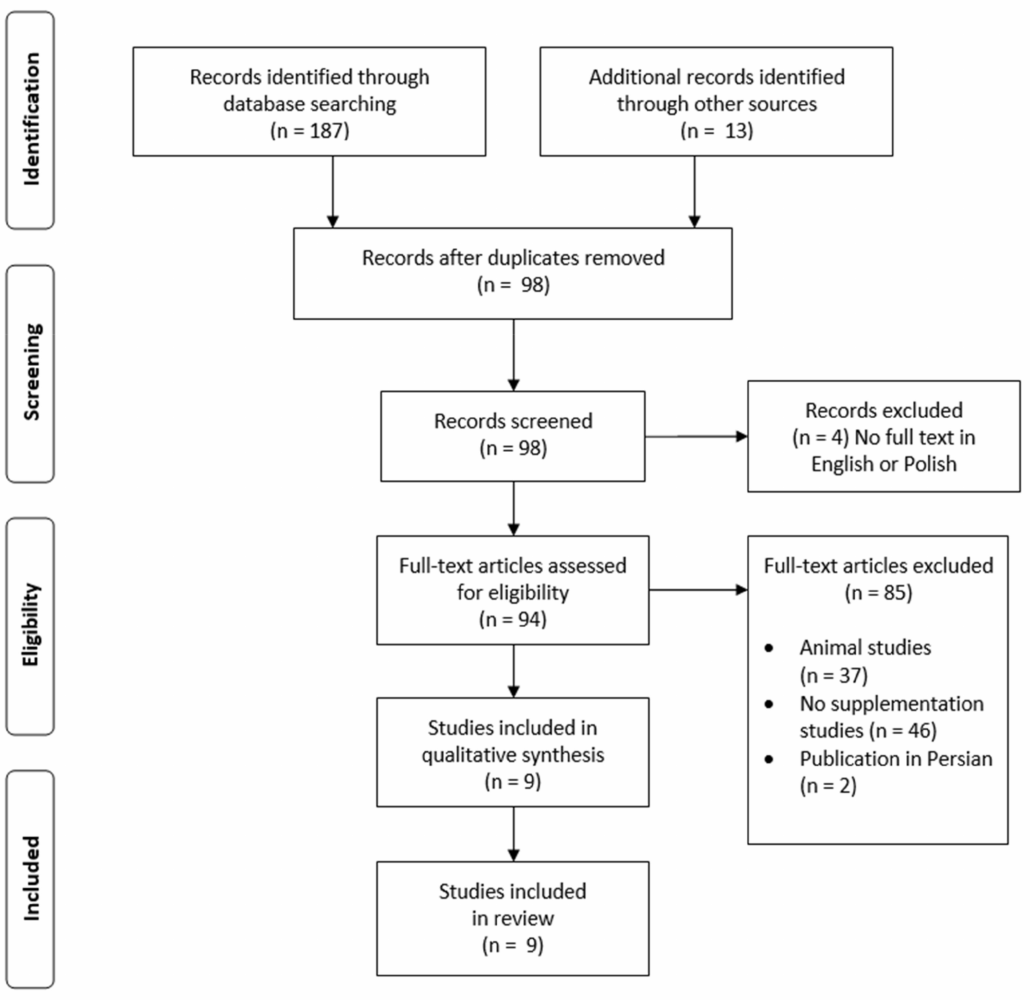
Figure 1. PRISMA flow diagram of the study